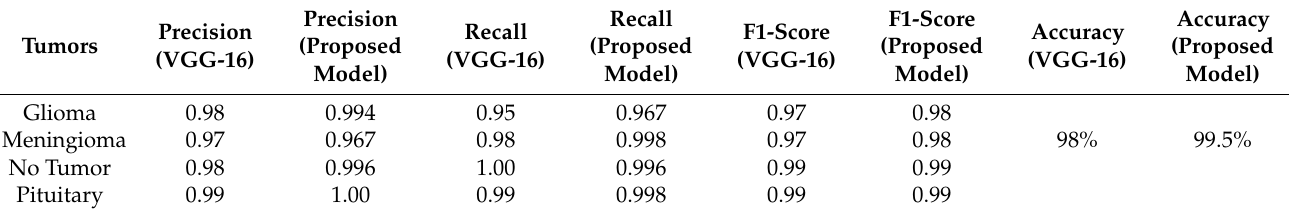
Table 7. Comparison of the proposed model with